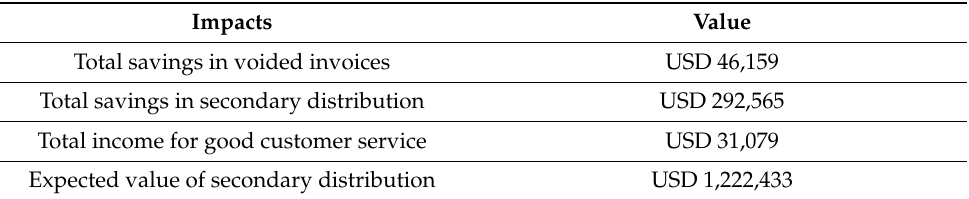
Table 16. Impact values generated by the implementation of the TMS.